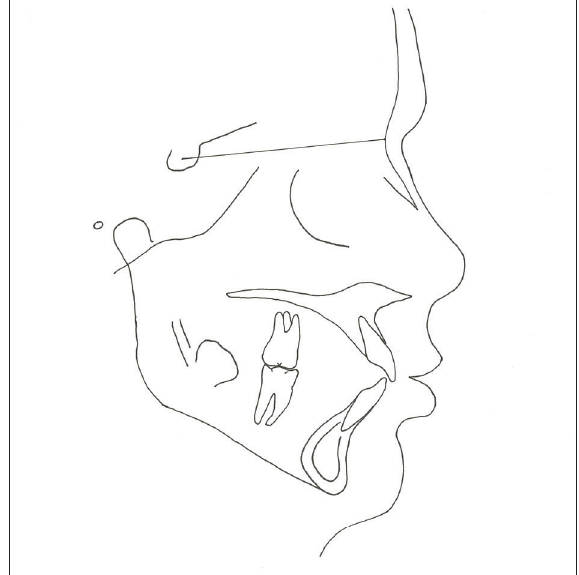
Figure 2b. Pre-treatment long- cone periapical (LCPA) radiograph demonstrating external inflammatory resorption and ankylosis-related (osseous replacement) resorption affecting the upper left central incisor. Figure 3. Tracing of pre-treatment lateral cephalometric